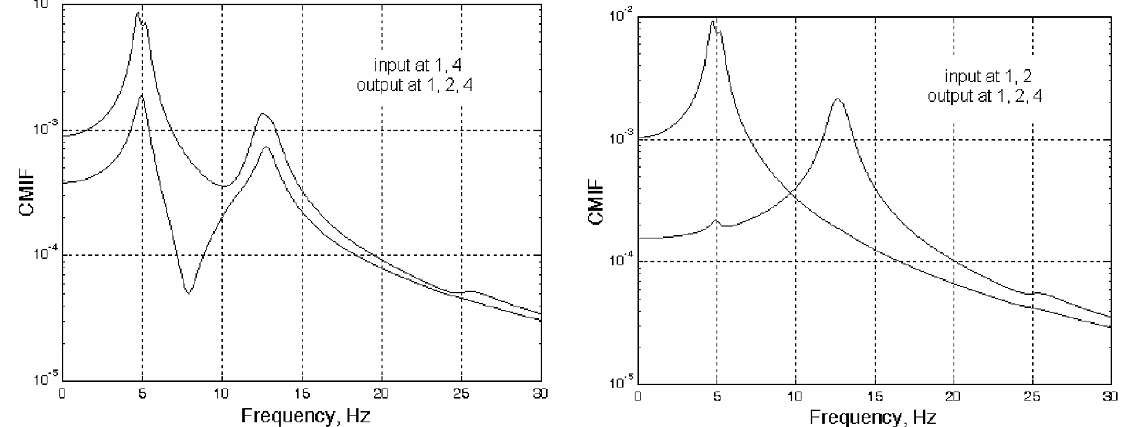
Fig. 6. CMIF for the 5-dof system, case 1. Fig. 7. CMIF for the 5-dof system, case 2.